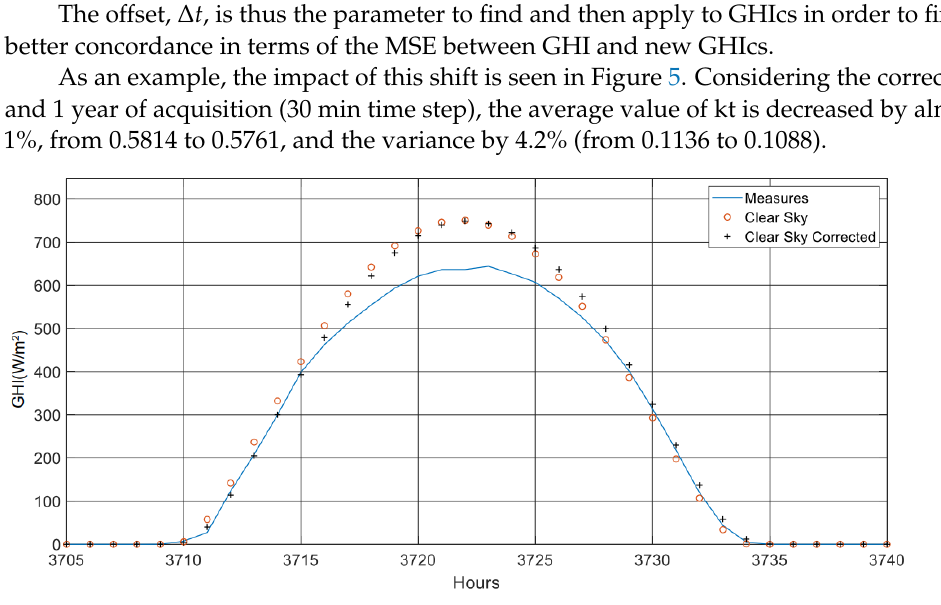
Visual validation: Measured data (SIAR) are plotted in a 2D graph (Figure 6); in the same graph are drawn the theoretical sunrise (red color) and sunset hour (green color).